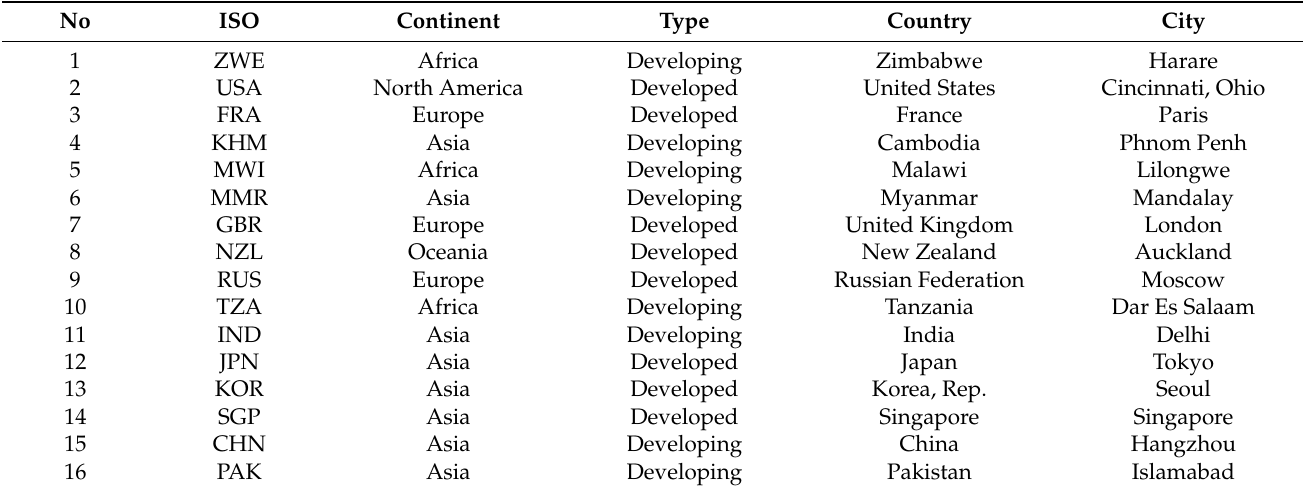
Table 1. List of case cities.